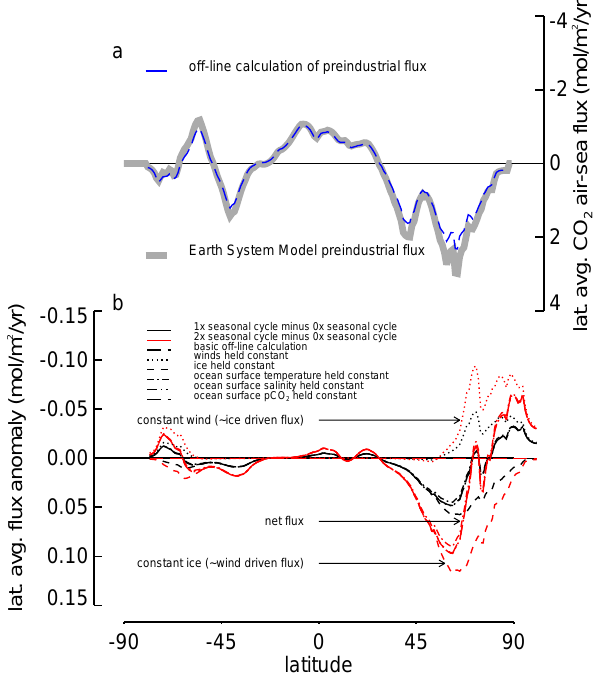
Fig. 6. (a) Latitudinally and annually averaged air-sea CO 2 flux simulated in (and calculated interactively by) the HadGEM2-ES pre-industrial interactive-CO 2 control simulation (gray), and off- line calculation of that air-sea flux from annually averaged temper- ature, salinity, wind-speeds, sea-ice concentrations, and atmosphere and ocean CO 2 concentrations (dashed blue line). (b) Offline calcu- lations showing the impact on the air-sea CO 2 flux of changing the CO atm seasonal cycle amplitude, presented as anomalies between 2 that calculated with a pre-industrial CO atm seasonal cycle (as calcu- 2 seasonal cycle lated interactively by HadGEM2-ES) and no CO atm 2 (black), and twice the pre-industrial CO atm seasonal cycle, and no 2 CO atm seasonal cycle 2